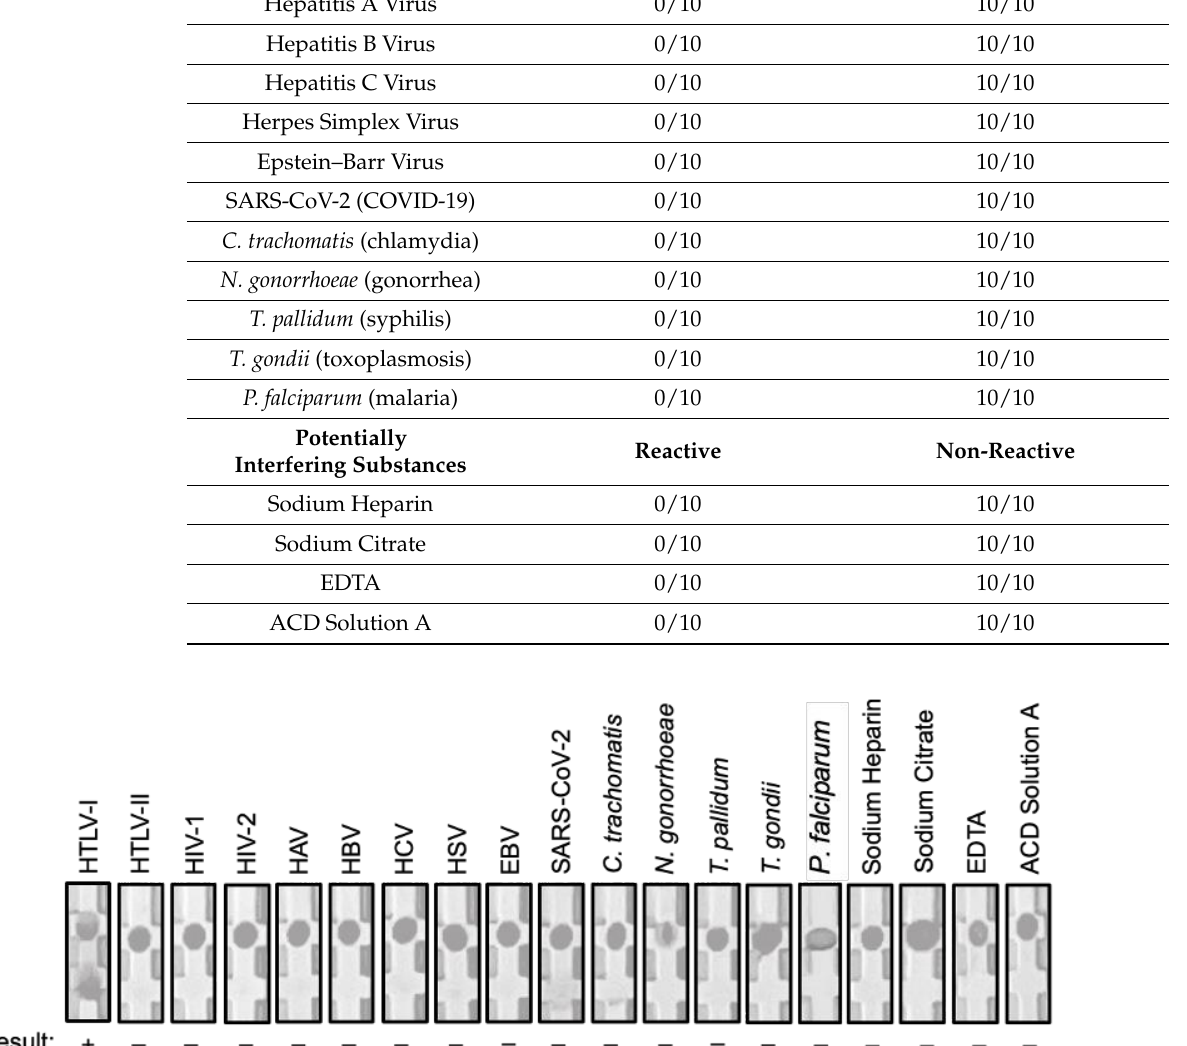
Figure 3. Representative image of the rapid screening test in cross-reaction studies with potentially interfering infections and substances. Serum specimens collected from infected individuals or spiked with substances were processed by the rapid screening test for HTLV-I then image captured. HAV, hepatitis A virus; HBV, hepatitis B virus; HCV, hepatitis C virus; HSC, herpes simplex virus; EBV, Epstein–Barr virus. Table 3. Cross-reaction studies with potentially interfering infections and substances. Potentially